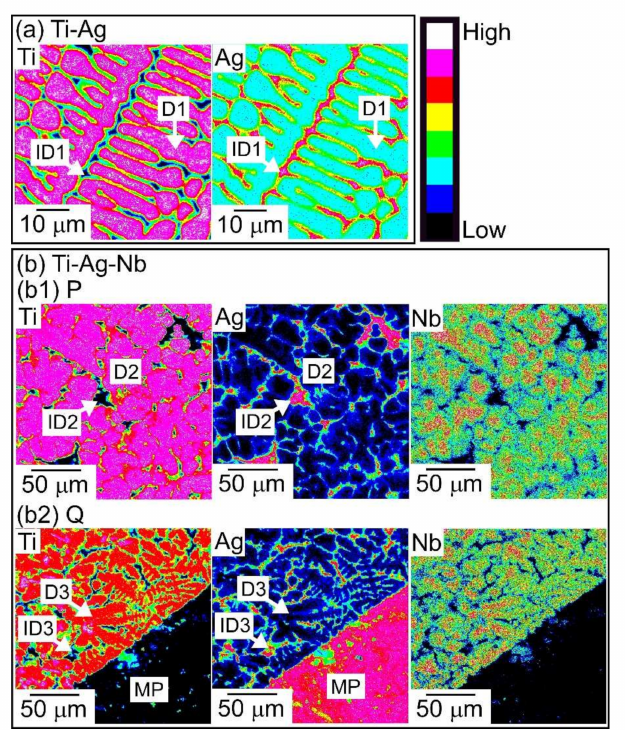
Figure 6. EPMA-WDS elemental mapping of the arc-melted ingots in the Ti 53.4 Ag 33.3 Nb 13.3 alloy, together with those of the binary Ti 66.7 Ag 33.3 alloy as a reference. ( a ) Ti 66.7 Ag 33.3 alloy, ( b ) Ti 53.4 Ag 33.3 Nb 13.3 alloy; ( b1 ) Central region corresponding to index P in Figure 5b1; ( b2 ) bottom region corresponding to index Q in Figure 5b1. The indices I, ID, and MP denote the dendrite region, interdendrite region, and macroscopic phase-separated region existed at copper hearth contacted region,